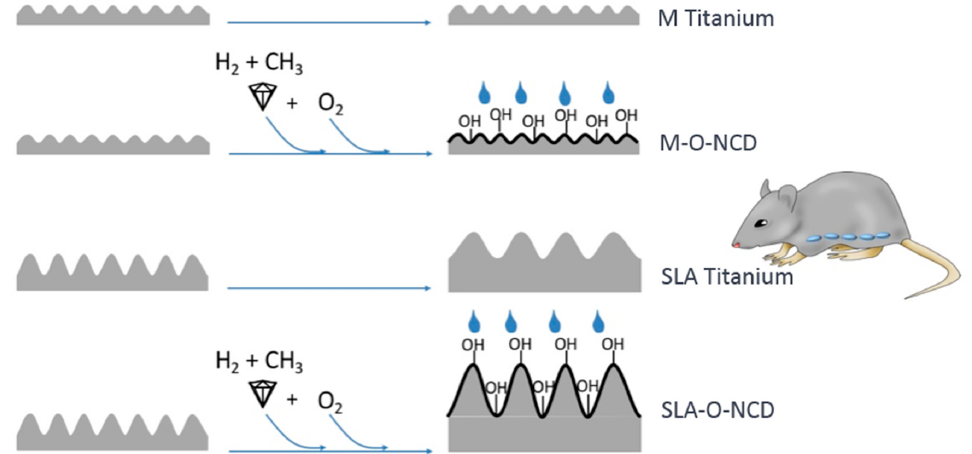
Figure 1. Study design showing the four different surfaces with different levels of roughness (machined versus sand-blasted/acid etched) and different hydrophilicity achieved through additional nano-crystalline diamond coating.